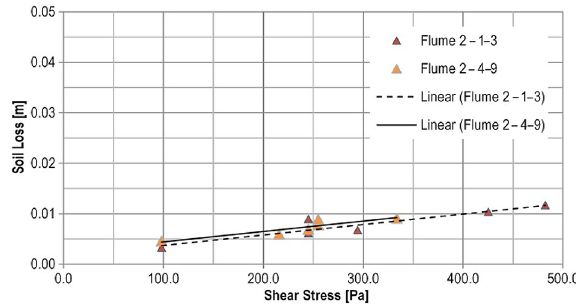
Fig. 11. Erosion rates flume 2 (vegetated); soil loss and shear stress, steep trend line = high erosion rate, focus on the upper (“1–3”) and lower (“4–9”) flume parts, September 2014